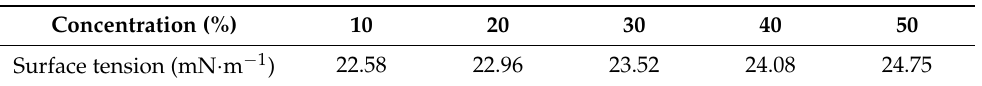
Table 1. Surface tension of siloxane solutions (concentrations 10, 20, 30, 40, 50%).